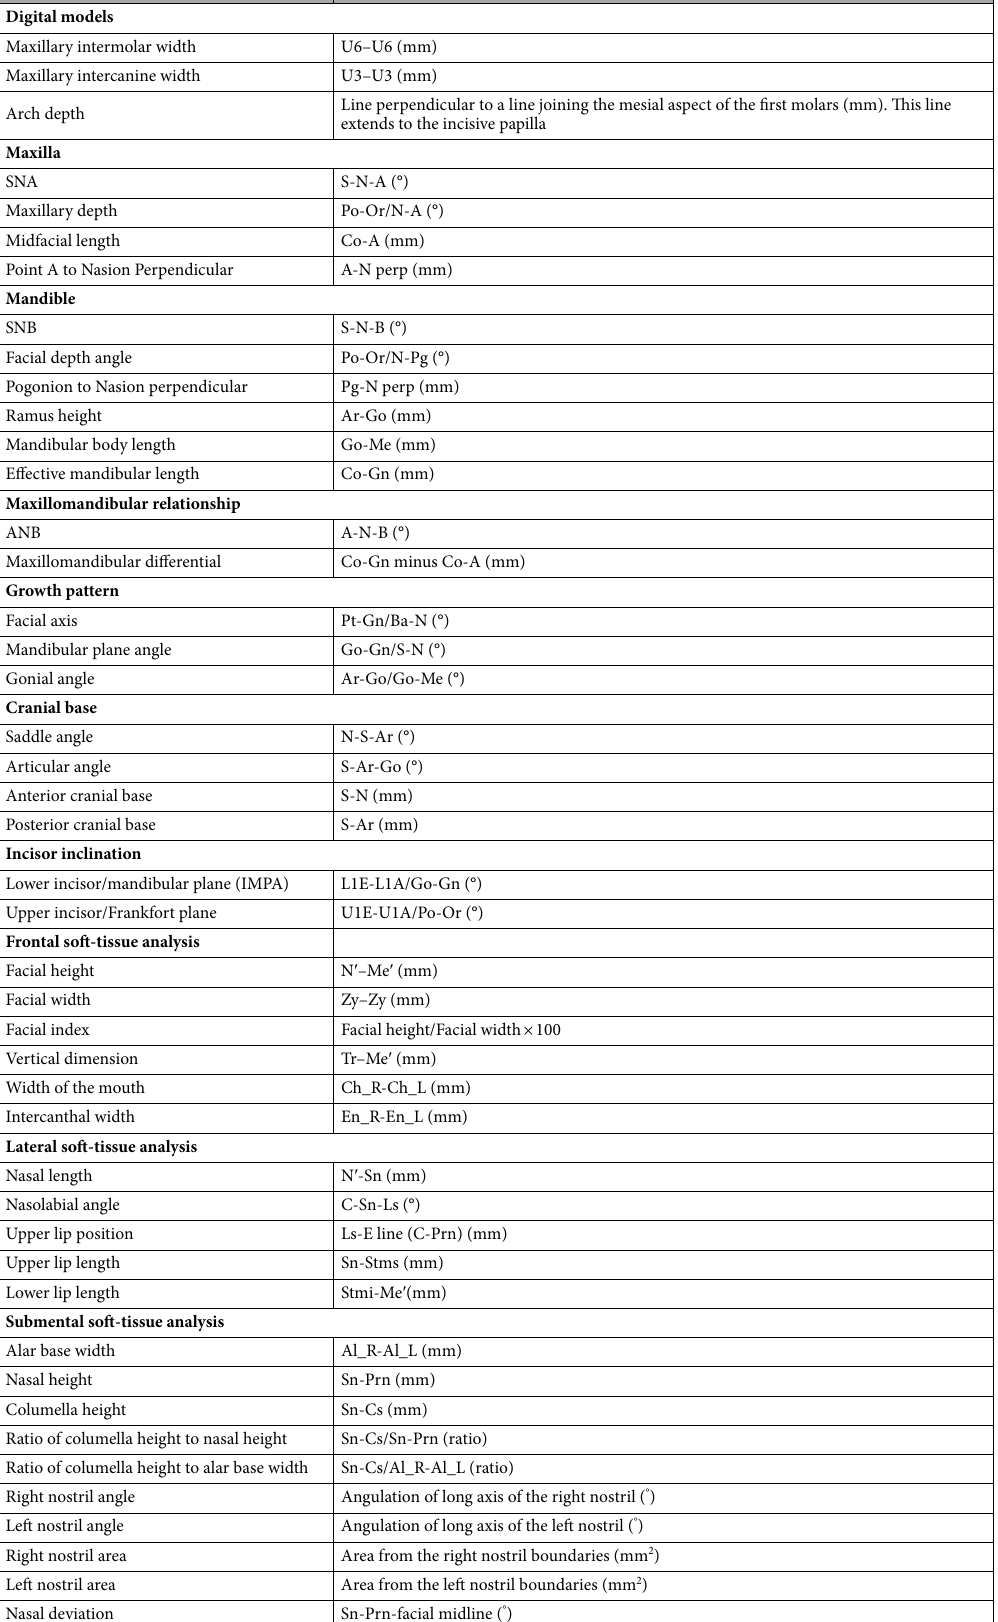
Table 5. Landmarks for measurements on cephalometries and facial